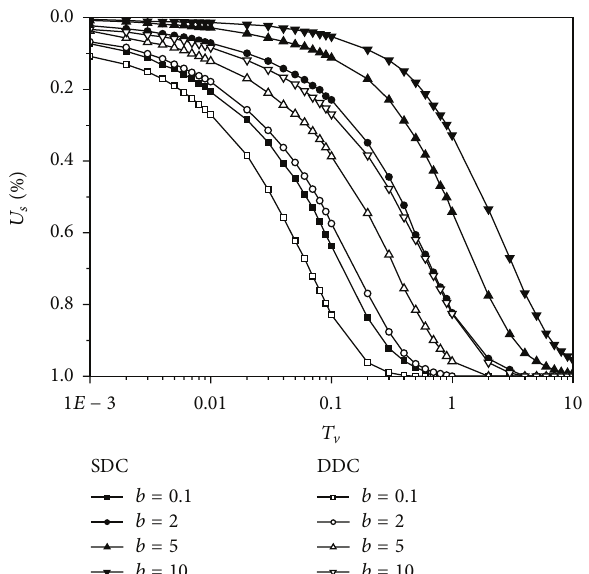
Figure 4: Consolidation curves with a uniform vertical additional stress initial excess pore pressure.